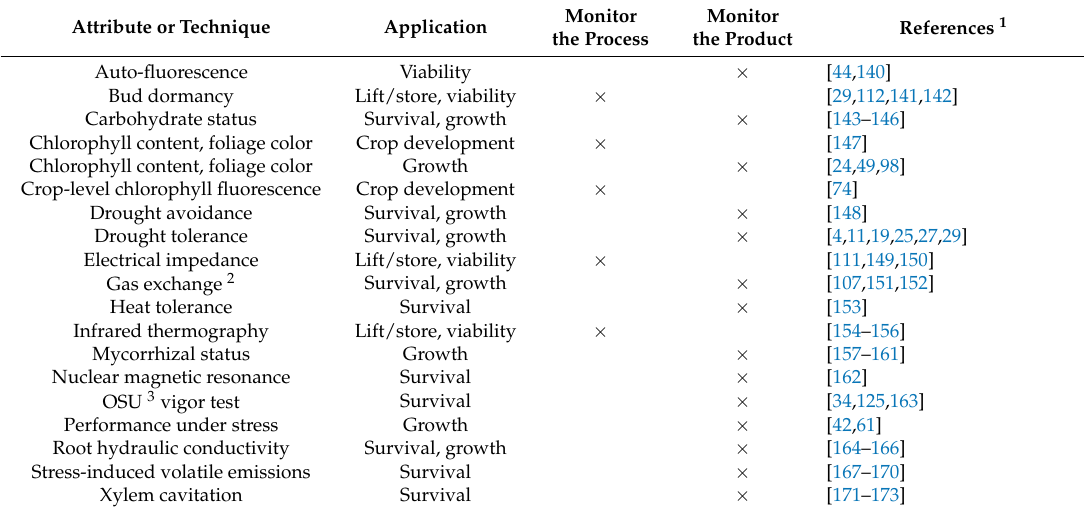
Table 4. Novel physiological attributes or novel measurement techniques for traditional physiological attributes, proposed for use in seedling quality-assessment programs to monitor either the process during nursery culture or the product at the end of culture, which were not adopted.